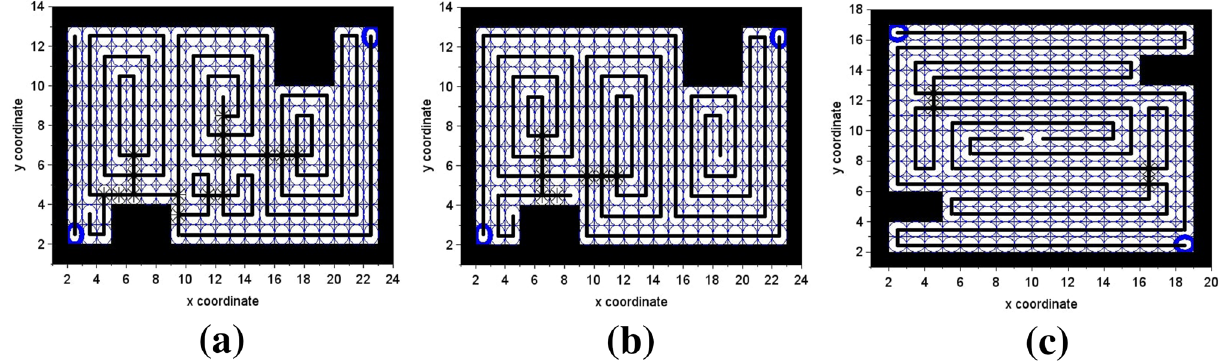
Fig. 10 Mobile robots with different initial positions and different environmental conditions